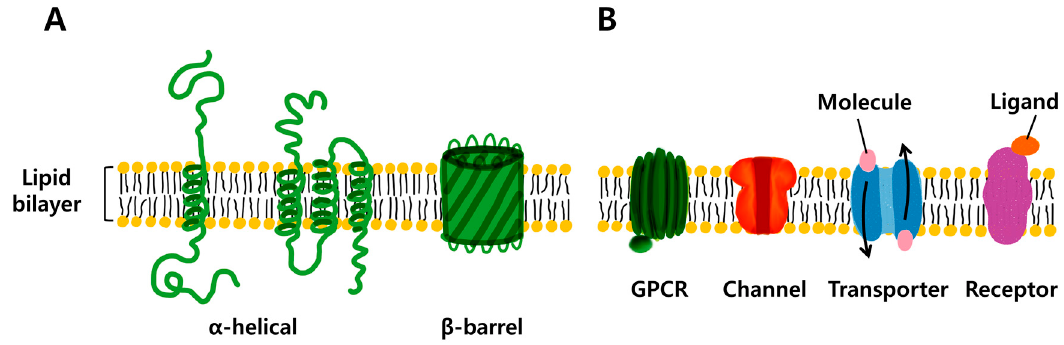
Figure 1. ( A ) Structure of alpha-helical and beta-barrel transmembrane proteins. ( B ) Schematic example of transmembrane protein; G-protein coupled receptors (GPCRs), ion channel, transporter, receptor.